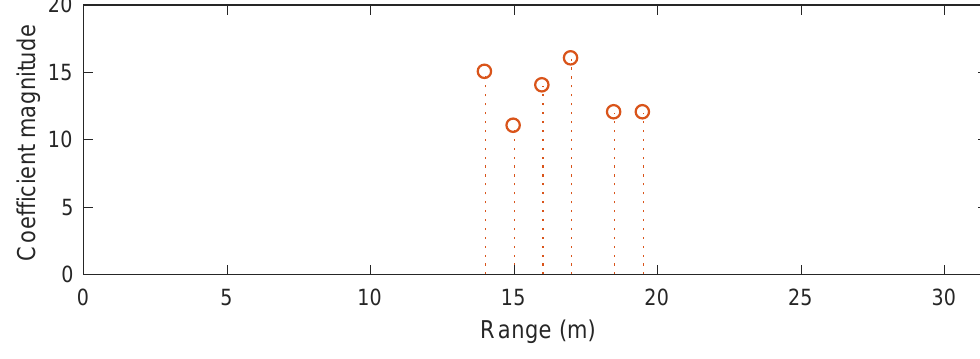
Figure 1. True range profile of synthetic target under consideration.